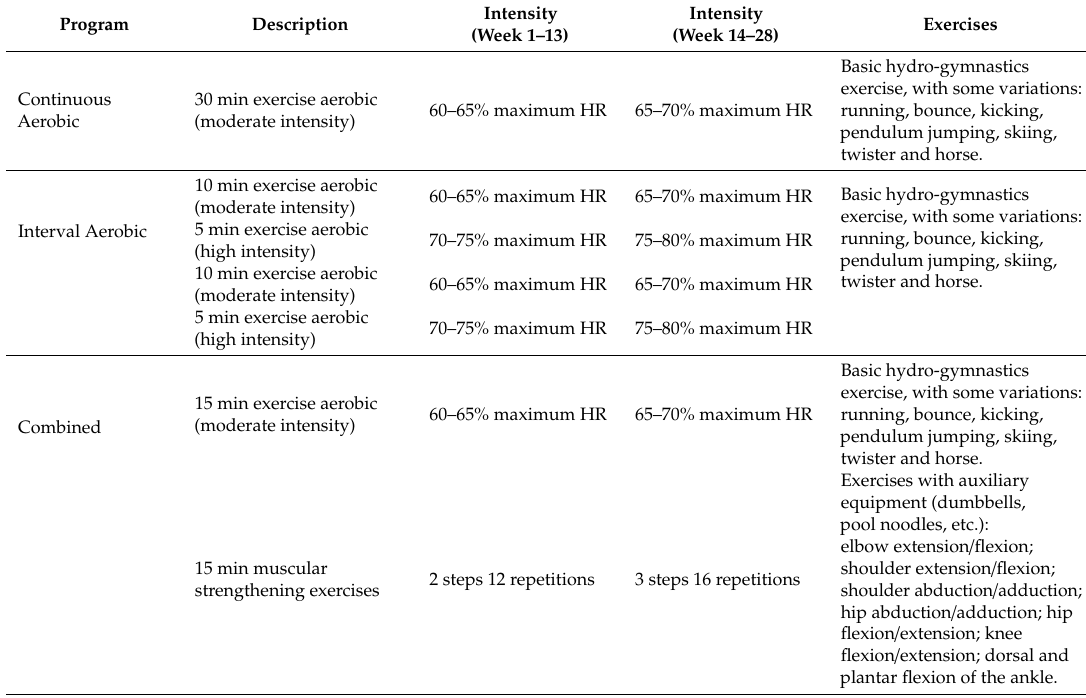
Table 1. Characteristics of the three physical exercise programs applied for 28 weeks (continuous aerobic, interval aerobic and